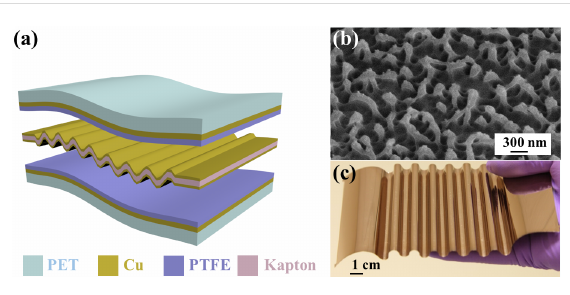
Figure 1: A flexible undulated electrode-based triboelectric nanogener- ator. (a) Schematic diagram of the fabricated u-TENG. (b) FESEM image of an inductively coupled plasma-etched PTFE film. (c) Repre- sentative picture of the as-prepared undulated electrode.